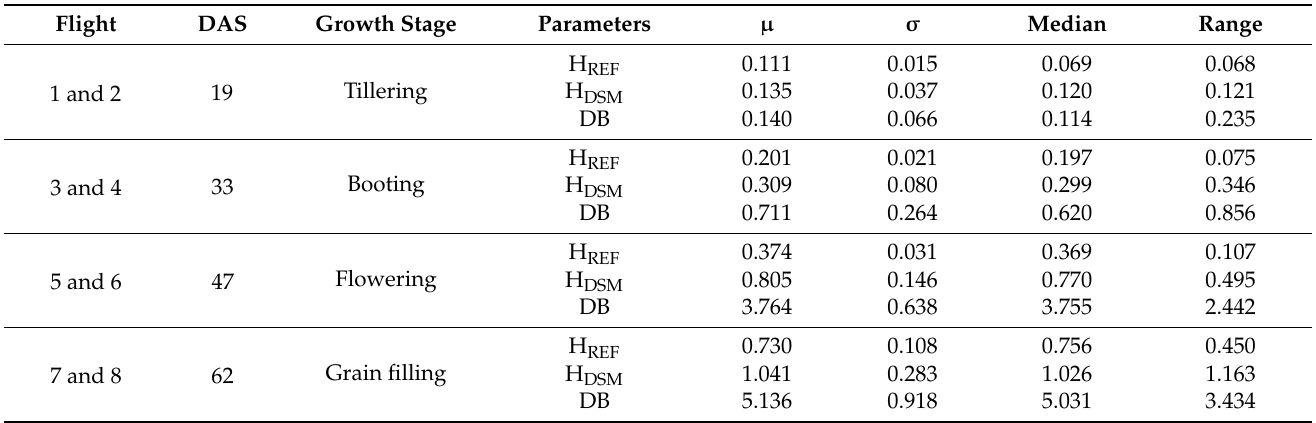
Table 6. Descriptive statistics for overall mean values for all parameters evaluated in the study.